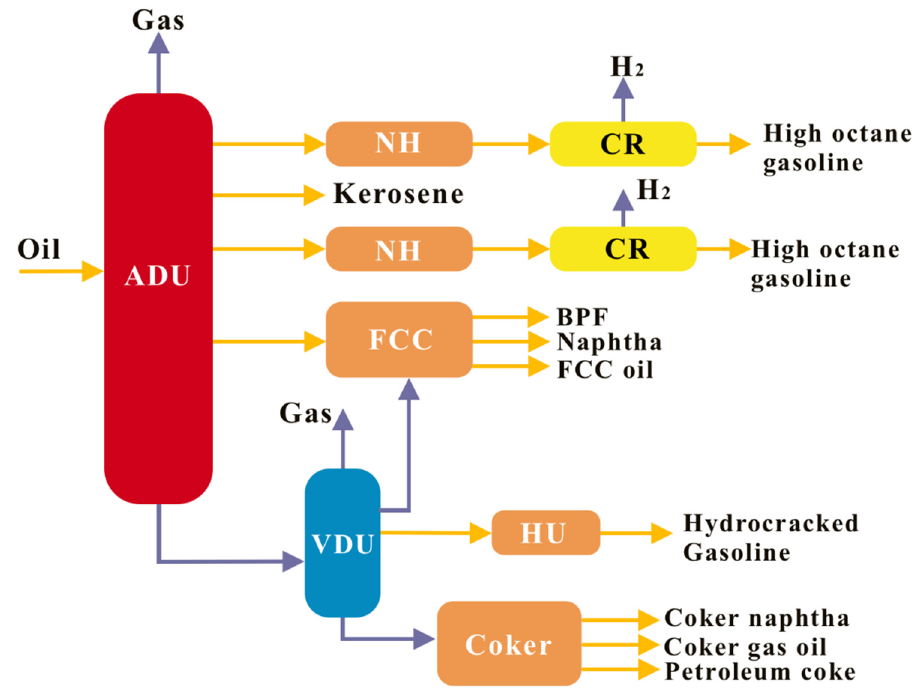
Figure 1. Possible mini-refinery configuration.